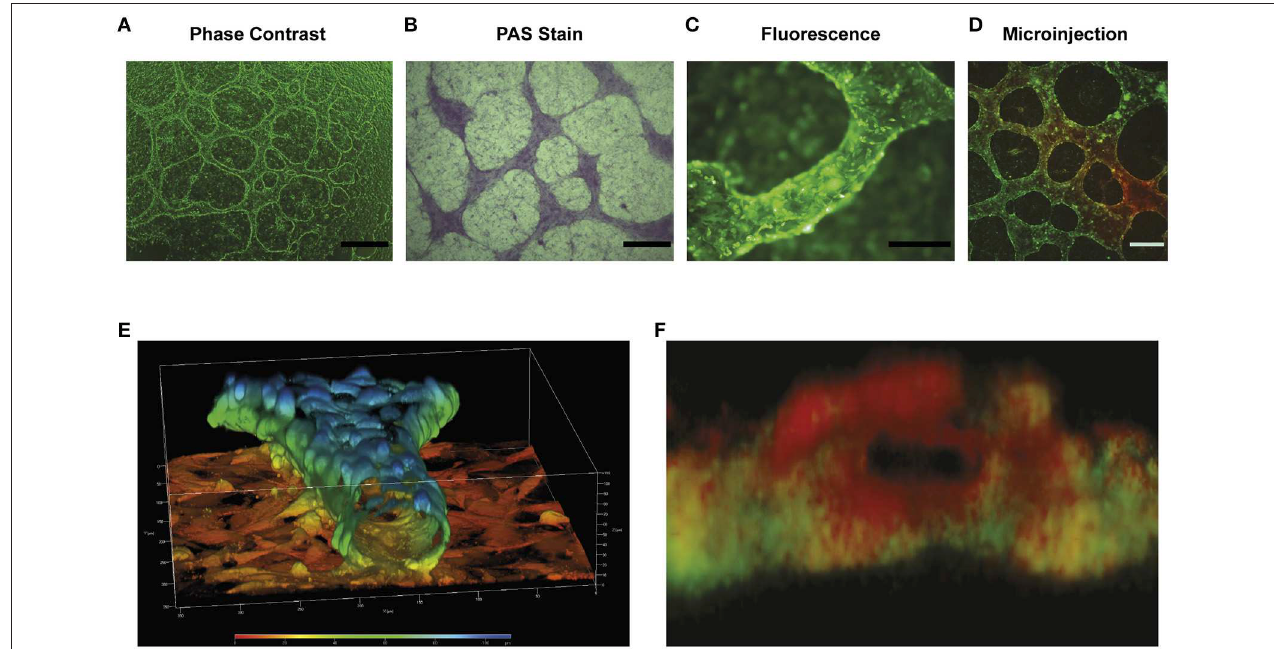
FIGURE 5 | Characterization of in vitro model of VM: (A) is a representative light microscope image of the tubular structures formed by the HEY ovarian cell line after 4 days in matrigel culture. Elevated tubular structures are observed above a cell monolayer. Size bar represents 500 µ m. (B) PAS stain showing that the elevated tubular structures possess a higher concentration of glycoproteins that cell monolayer present below. Size bar represents 500 µ m. (C) Epifluorescence image of the tubular structures of the formed in the HEY cell line transfected with GFP (HEY-GFP). Note the difference in height of the tubular structure compared with cell monolayer below and that the tubular structure ( ∼ 100 µ m in diameter) is composed of numerous cancer cells. Size bar represents 200 µ m. (D) A dye micro injection of 4-day old HEY-GFP culture, showing that these structures are capable of moving a colorant dye within their interior. Size bar represents 200 µ m. (E) Confocal 3D reconstruction of the tubular structures found in the HEY-GFP cell lines using ZEN 2012 program. The color scale represents the height in culture over the cell monolayer. Note how the cells form a tubular hollow structure with a central lumen. The size bar demonstrates that the structure is ∼ 80 µ m in diameter. (F) A 3D reconstruction of a cross section of the tubular structure showing the PAS positive (red) show up preferentially on the luminal side of the tubular structure, while the green cancer cells are confined to the outer sides (as schematically represented in Figure 1 ). Size bar represents 100 µ m.